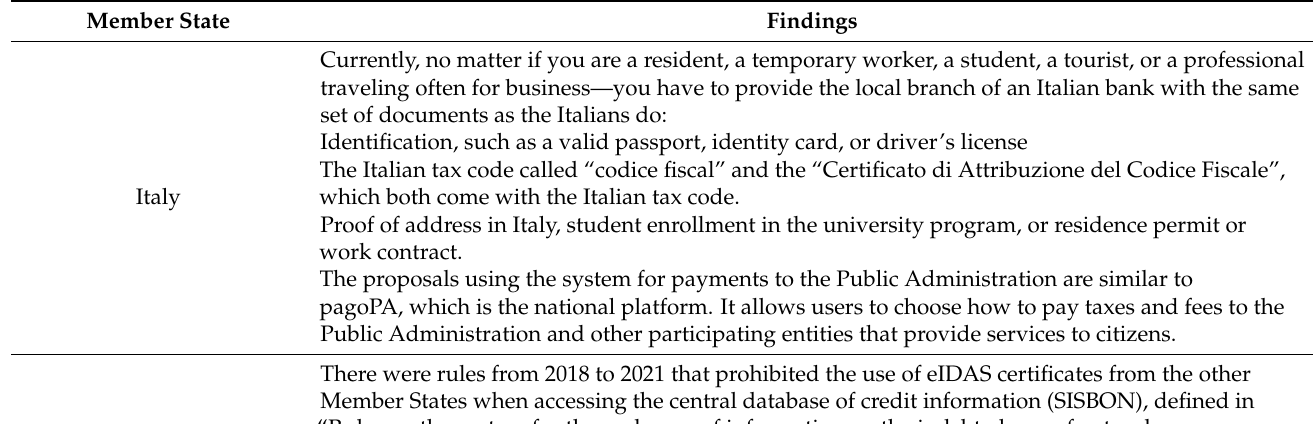
Table 2. Organizational independence for the sampled